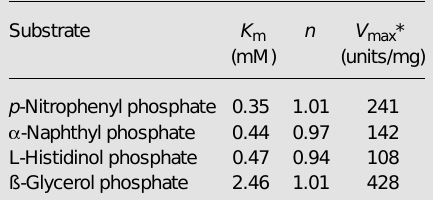
Table 5 - Summary of kinetic constants for the enzymatic hydrolysis of some organic esters at 37 o C, pH 8.9. *Calculated from double-reciprocal plots. For de- tails, see Material and